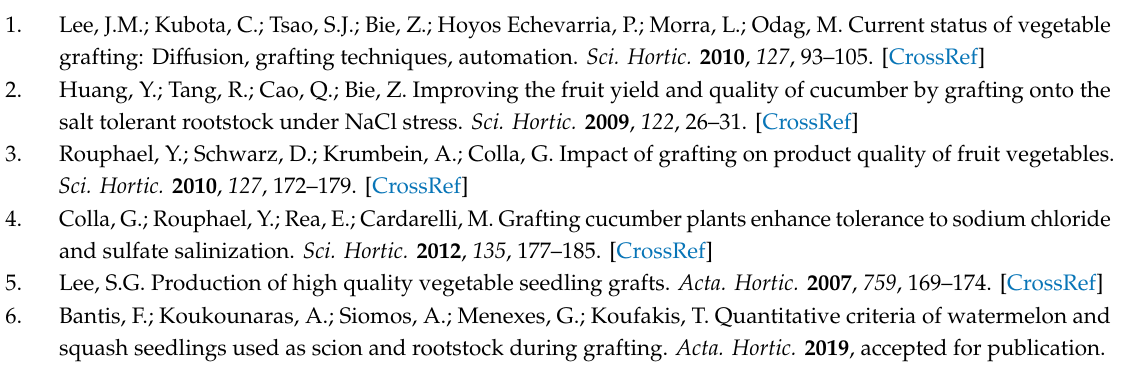
Table S1: Morphological, growth and colorimetric parameters of grafted watermelon seedlings obtained 7 days after grafting as a ff ected by watermelon (scion) or interspecific squash (rootstock) quality categories. Table S2: Morphological, growth and colorimetric parameters of grafted watermelon seedlings obtained 14 days after grafting as a ff ected by watermelon (scion) or interspecific squash (rootstock) quality